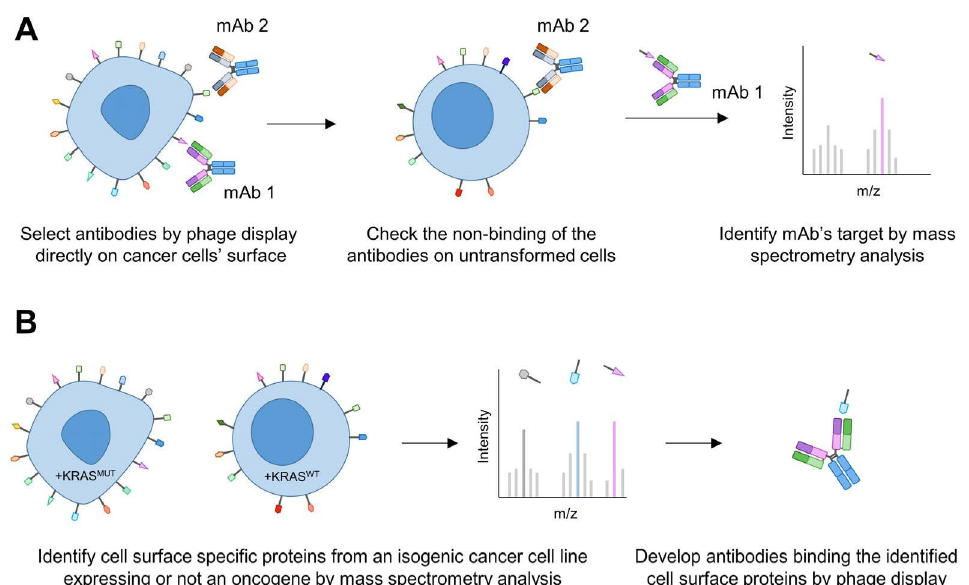
Figure 3. Discovery of novel cell surface proteins with antibodies. ( A ) Selection of mAbs directly binding to cancer cells by phage display and that do not bind to untransformed cells. Next, their target is identified by mass spectrometry analysis. ( B ) Determination of the surfaceome of cancer cells expressing an oncogene (e.g., mutant KRAS, KRAS MUT ) compared to the same cell line not expressing the oncogene (e.g., wild-type KRAS, KRAS WT ) to discover oncogene-dependent cell surface proteins by mass spectrometry analysis. mAbs are then selected by phage display against these newly discovered proteins.